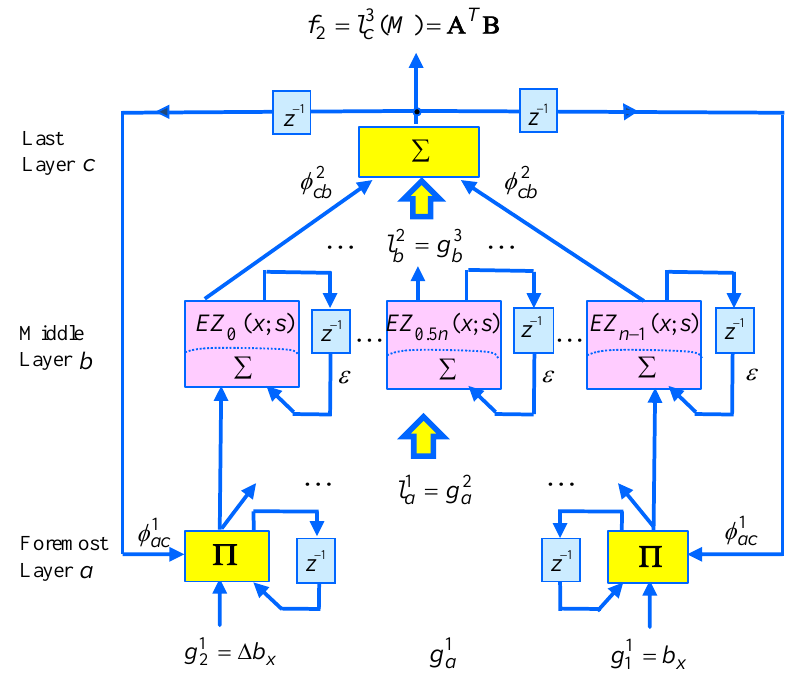
Figure 4. Constitution of the RREZPNN.